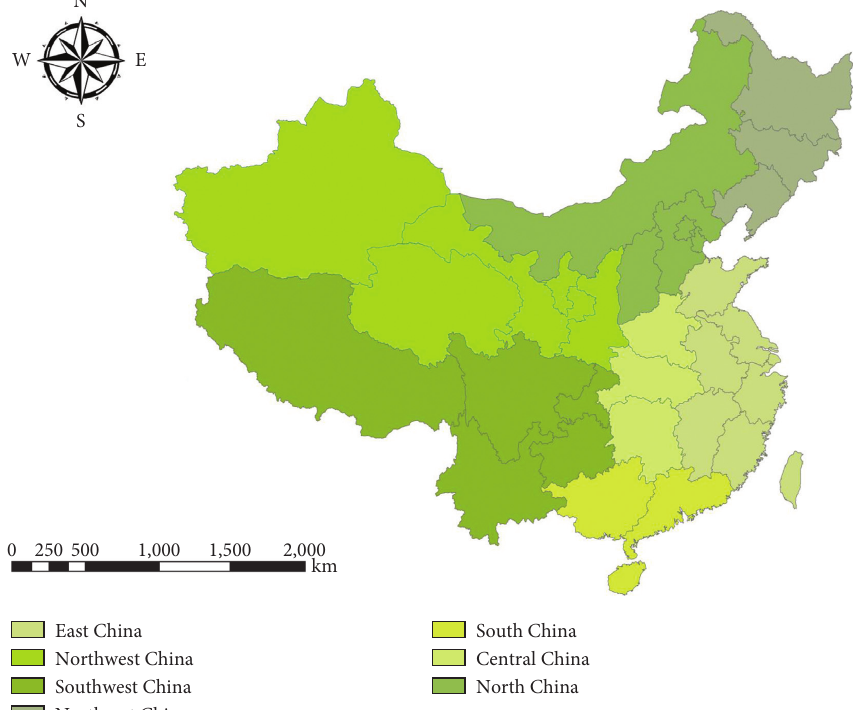
Figure 1: Distribution map of regions in